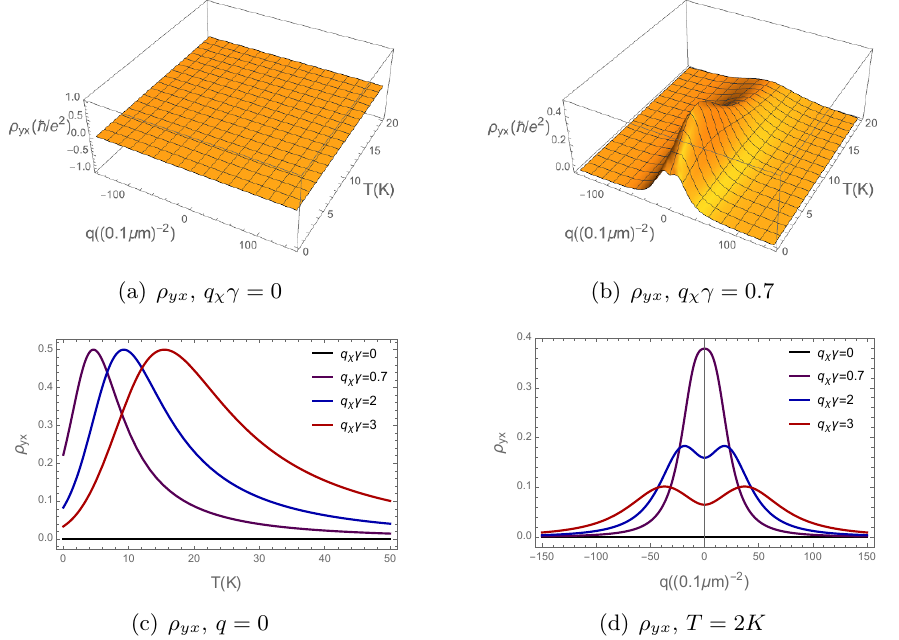
Figure 13 . The charge and the temperature dependence of the transverse resistivity without (a) and with (b) magnetic impurity. (c) The temperature dependence of (cid:26) yx at the charge neutrality point. (d) The charge density dependence of (cid:26) yx at low temperature ( T = 2 K ) with di(cid:11)erent value of q (cid:31) (cid:13)